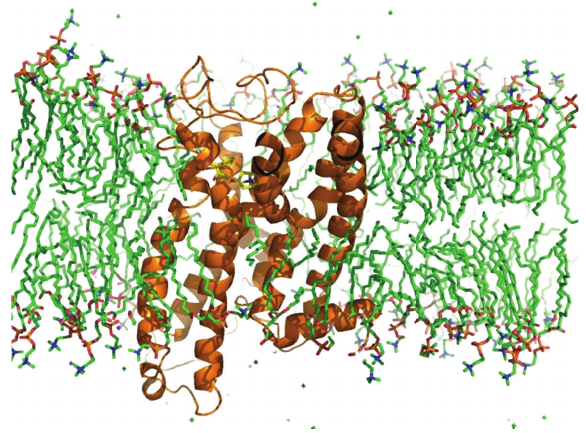
Figure 1: Snapshot of the system showing a ribbon representation of the M3 receptor with N-methylscopolamine bound into the orthosteric binding pocket, surrounded by POPC lipids. Waters have been removed for